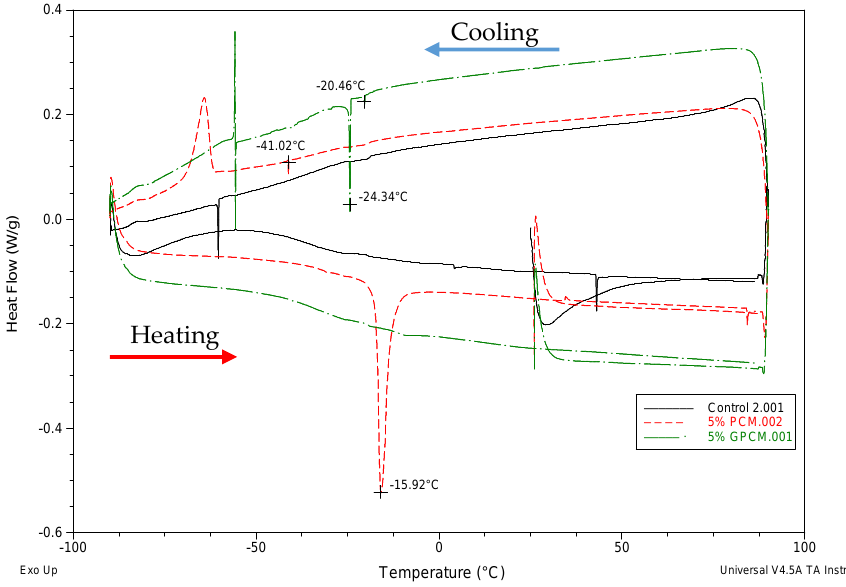
Figure 12. DSC diagram for control, 5%PCM, and 5%GPCM binders.